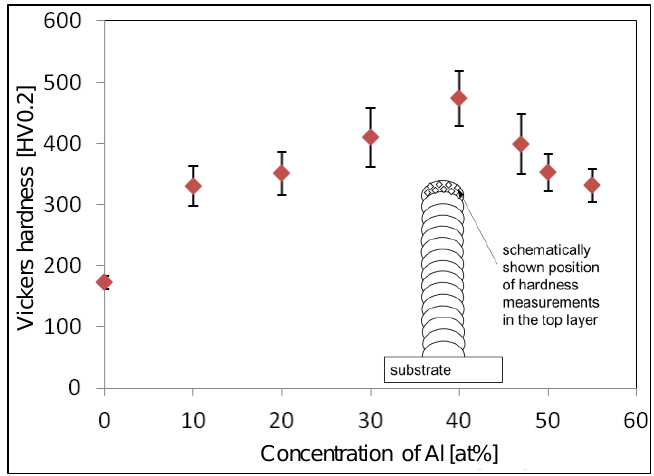
Figure 8. Hardness values of Ti – Al alloys dependent on aluminum concentration.